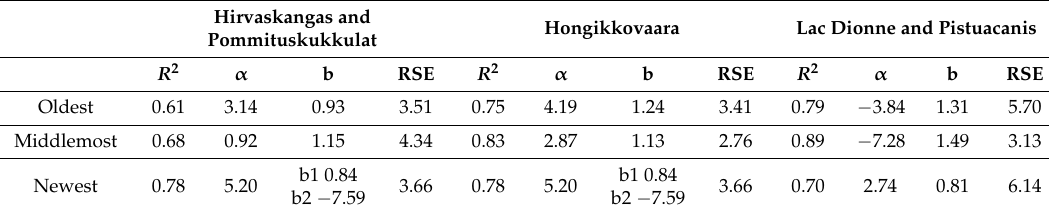
Table 2. The calibration model parameters for the oldest, middlemost and newest aerial photographs. R 2 -column shows the model coefficient of determination, α the intercept, b the slope, and (RSE) the residual standard error. In the calibration model for the newest photographs in the Finnish landscapes, b1 is the interpreted canopy cover and b2 is the proportion of P. abies of the interpreted canopy cover.